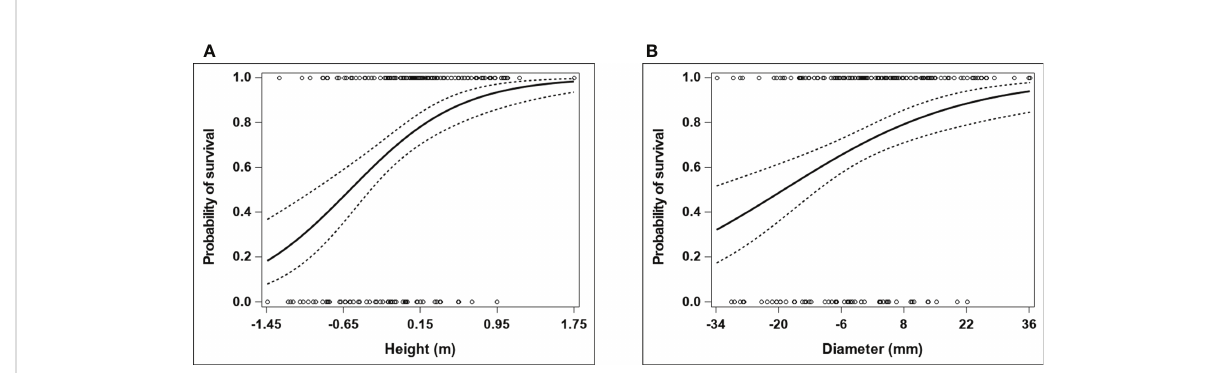
FIGURE 1 Expected probability of tree survival as a function of growth performance in E. pauci fl ora . The growth performance attributes (height and diameter) and tree survival (considered as a fi tness component) were assessed at ages 2 and 7 years from planting, respectively. The plots represent fi tted individual selection surfaces (and corresponding 95% con fi dence intervals) for (A) height and (B) diameter, based on a logistic regression model that comprised a linear term for the focal performance covariate in the linear predictor. The horizontal axis refers to absolute within-population deviations (i.e. population-mean centered observations) for a given growth performance variable. The actual observations for the fi tness component (0 = dead tree; 1 = alive tree) are indicated with